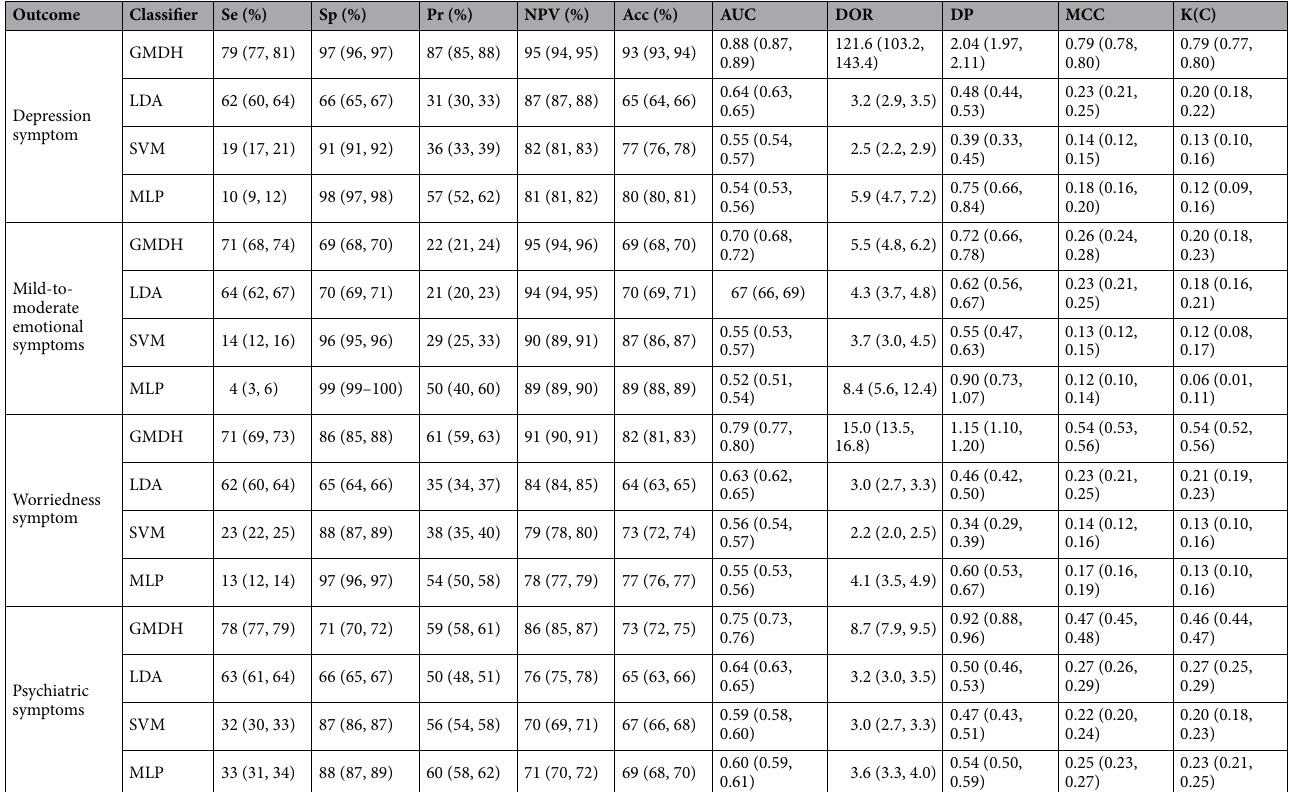
Table 4. The performance of the different classifiers and their CI 95% based on the cross-validated confusion matrix. Se sensitivity, Sp specificity, Acc accuracy, Pr precision, F1S F1-Score, AUC area under the receiver operating characteristic (ROC) curve, LR likelihood ratio, DOR diagnosis odds ratio, MCC Matthews correlation coefficient, DP discriminant power, K(C) Cohen’s kappa coefficient, NPV negative predictive value. The entire AUC and K(C) values were statistically significant ( p < 0.05). Statistical power (Power), false alarm (FA), and F1-score (F1S) values could be directly calculated as Power = Se, FA = 1 − Sp(%)/100, and F1S = 2 * Se * Pr/(Se +